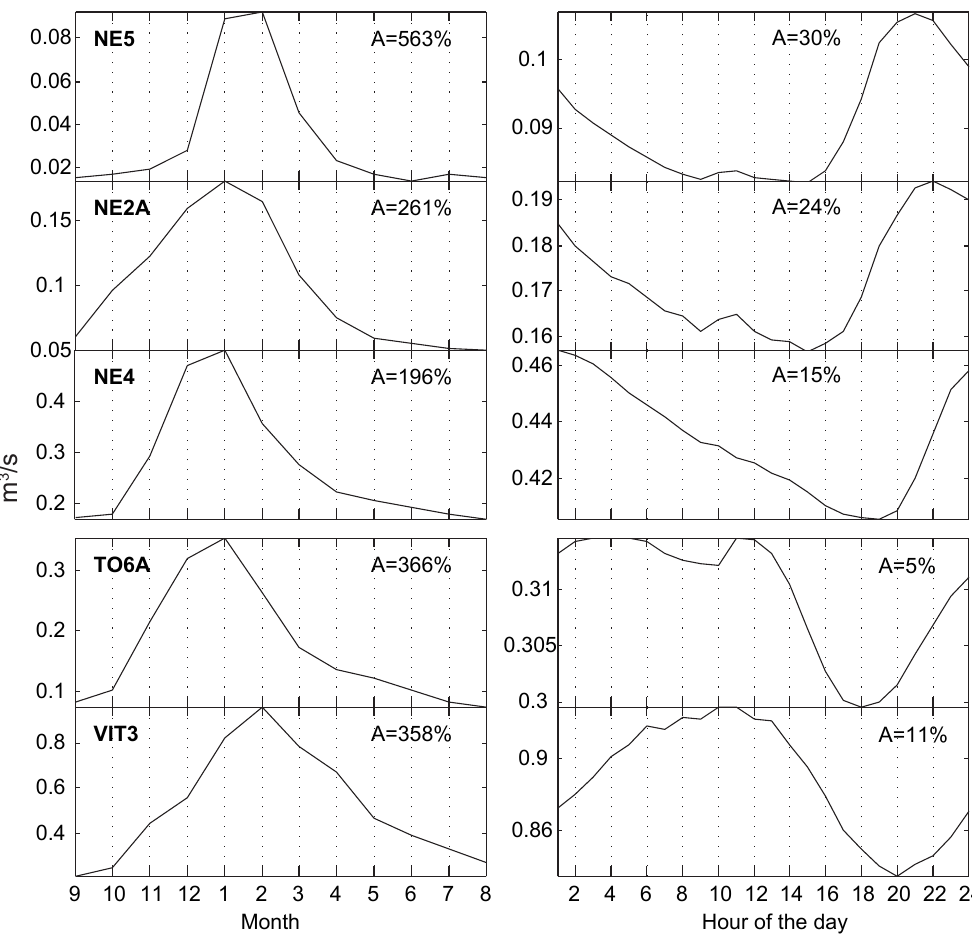
Fig. 2. Left: mean monthly discharge (2003/2004–2007/2008). Right: mean hourly discharge in January and February (2003/2004– 2007/2008). A is the relative variation of the maximum value with respect to the minimum value. NE-5, NE-2A and NE-4 stations are located in the Estrecho River catchment (upper panel), while TO-6A and VIT-3 stations are located in the Potrerillos River catchment (lower panel).